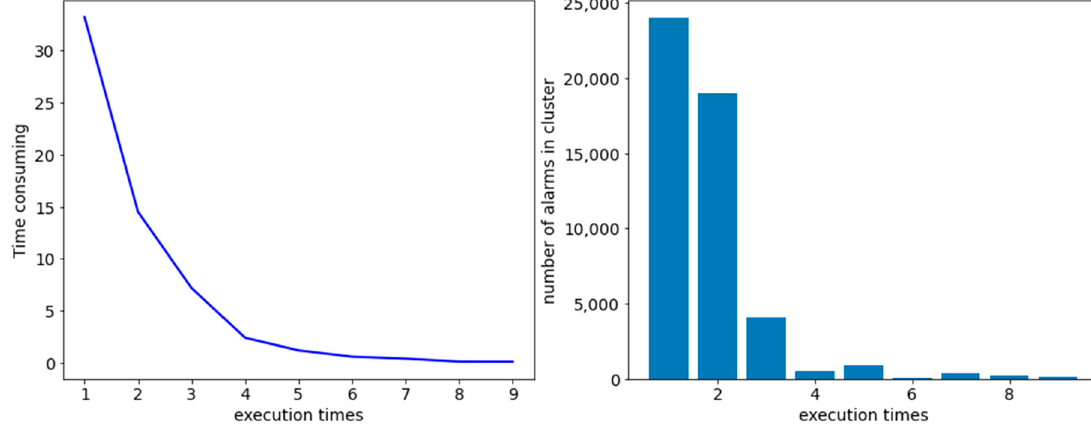
Figure 16. Time consuming and alarm clustering results versus the execution times of WOAHC-L.